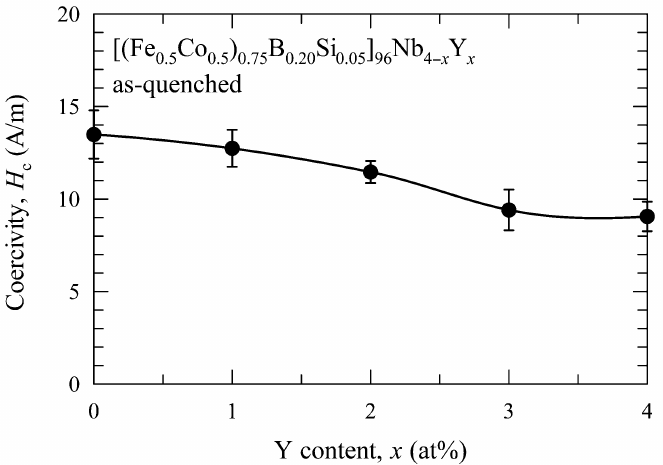
Figure 8. Coercivity ( H c ) of [(Fe 0.5 Co 0.5 ) 0.75 B 0.20 Si 0.05 ] 96 Nb 4− x Y x alloys in an as-quenched state as a function of Y content. The graph shows the mean value for the five specimens (closed circles). The error bars represent the 95% confidence limits (±2 × standard